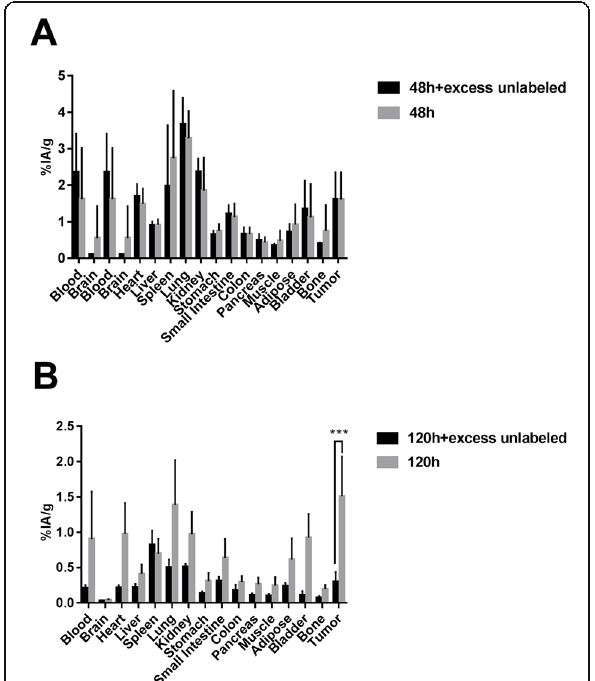
Fig. 6 Comparison of 131 I-PD-L1-Mab tumor uptake and post- blocking uptake in subcutaneous RKO xenograft mice. a After intravenous injection of 131 I-PD-L1-Mab at 48 h, blocking group mice were injected with an excess of unlabeled PD-L1 antibody at the same time as 131 I-PD-L1-Mab was injected. b After intravenous injection of 131 I-PD-L1-Mab at 120 h, blocking group mice were injected with an excess of unlabeled PD-L1 antibody at the same time as 131 I-PD-L1-Mab was injected. The data are expressed as means (%IA/g) ± SD at each time point after injection, *** p <